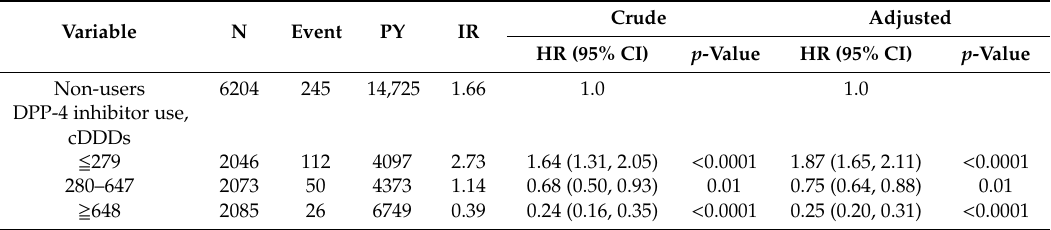
Table 3. Incidence rate and hazard ratio of allergic rhinitis in diabetes patients by cumulative dose of DPP-4 inhibitor use compared to non-users.